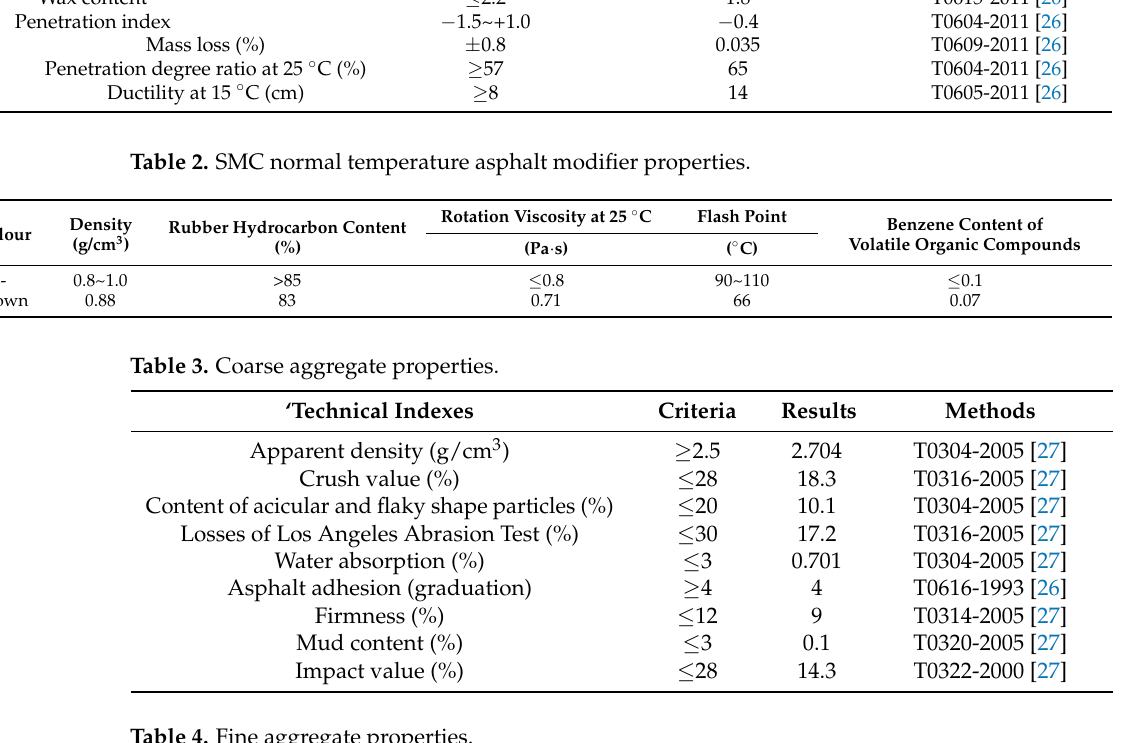
Table 4. Fine aggregate properties.